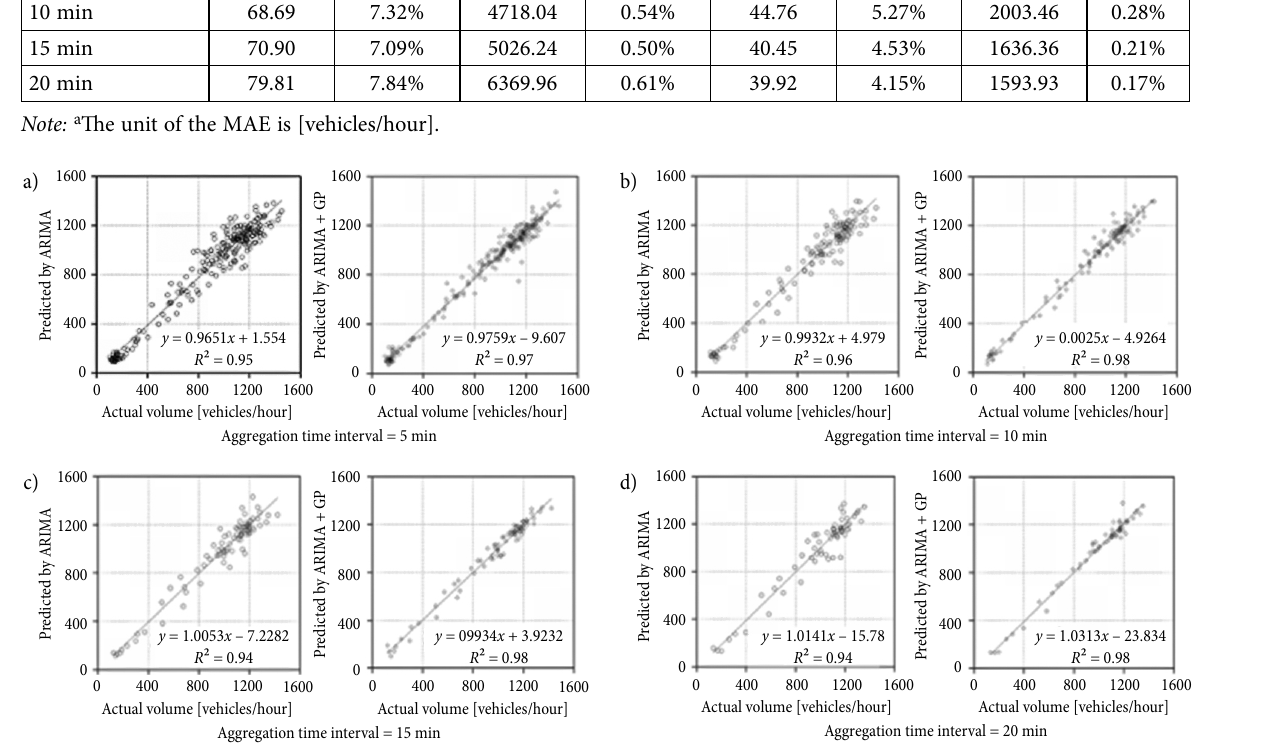
Fig. 8. Predicted versus actual volumes for different aggregation time intervals at Site A